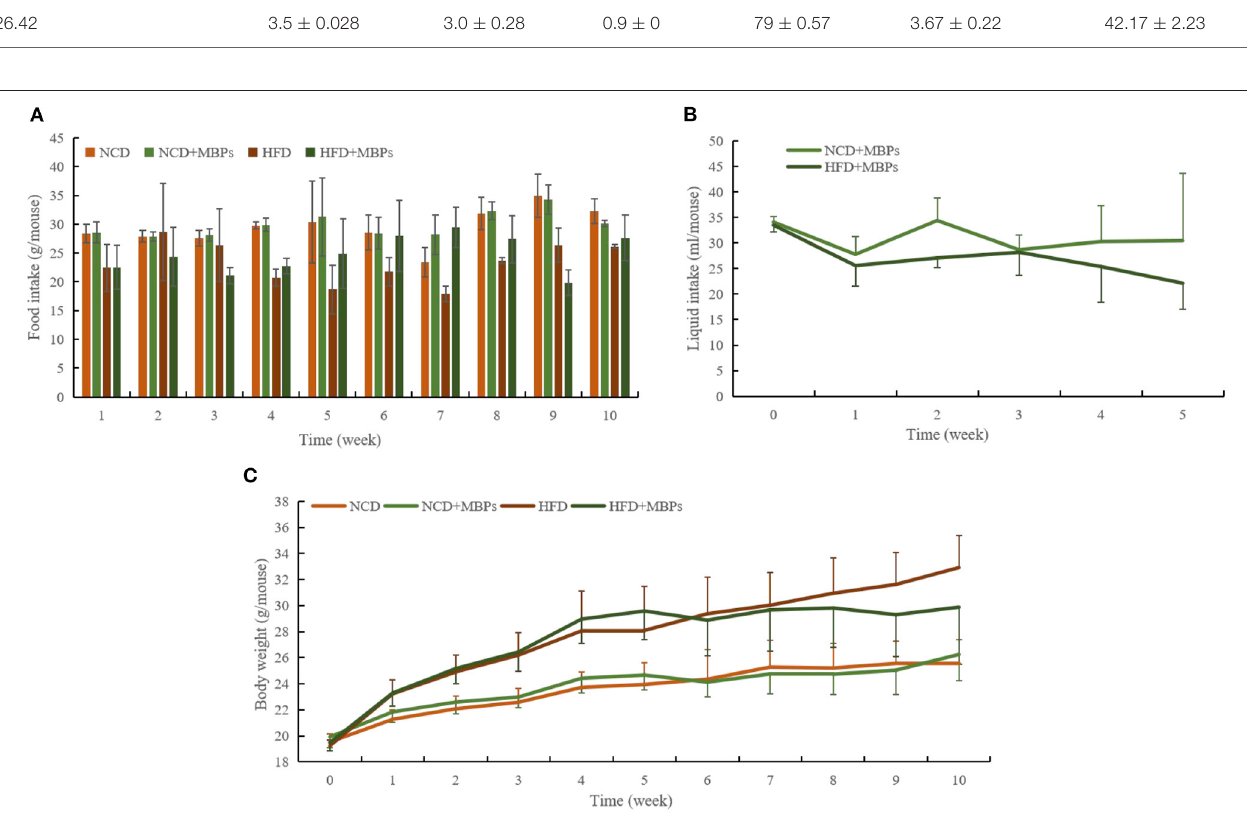
Arb; Aux gas flow rate, 25 Arb; capillary temperature, 350 ◦ C;